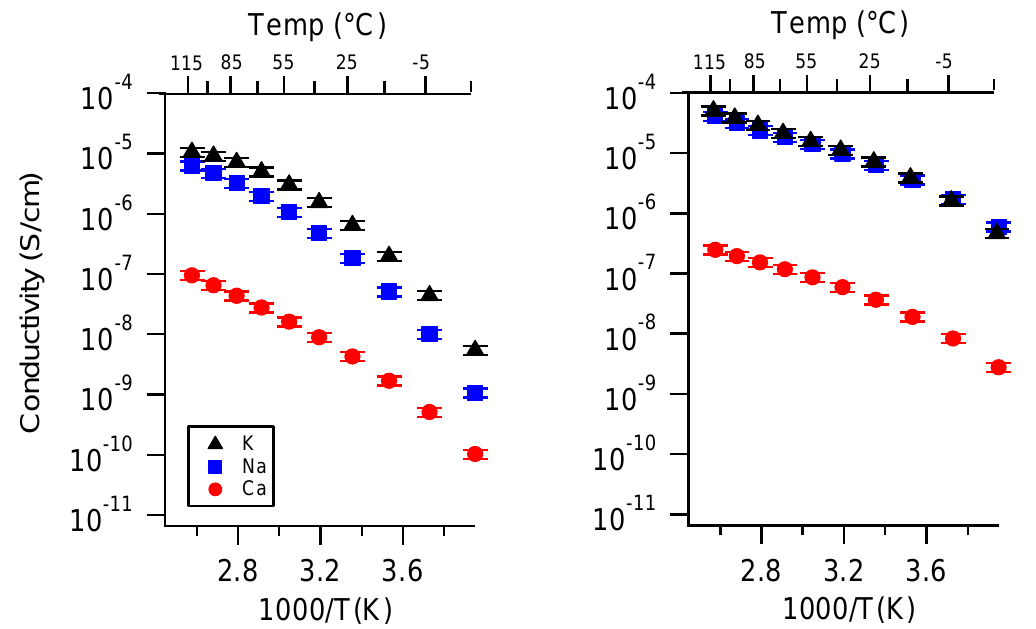
Figure A4. Conductivity as a function of cation for PEGDMA1000_low_SSM (left) and